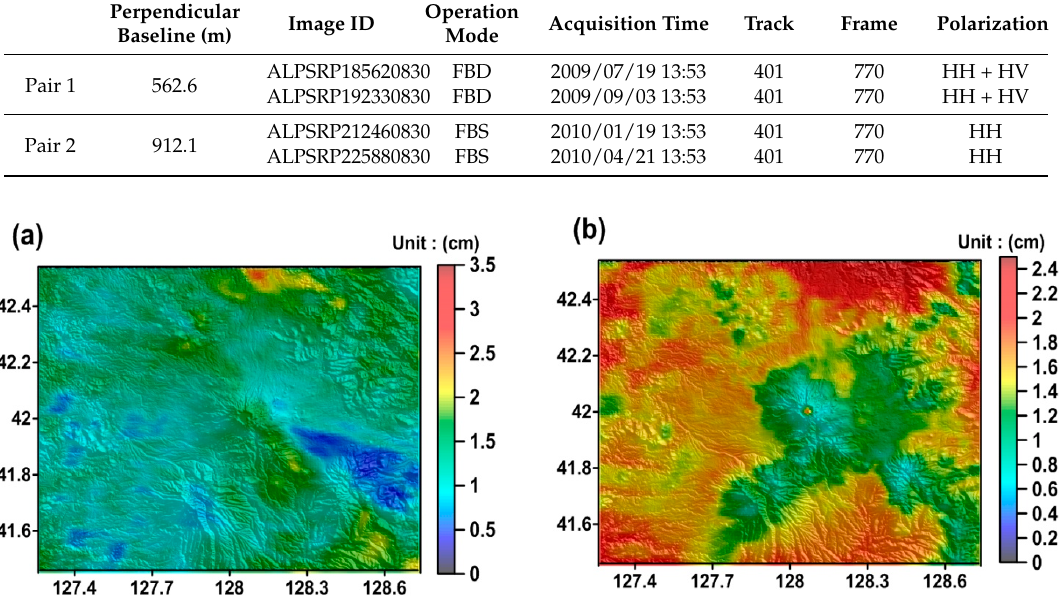
Figure 3. Interpolated MODIS TPW (Total Perceptible Water) maps over Mt. Baekdu: ( a ) TPW map for master SAR image acquisition time (19 July 2009); ( b ) TPW map for water vapor map in slave SAR image acquisition time (3 September 2009).